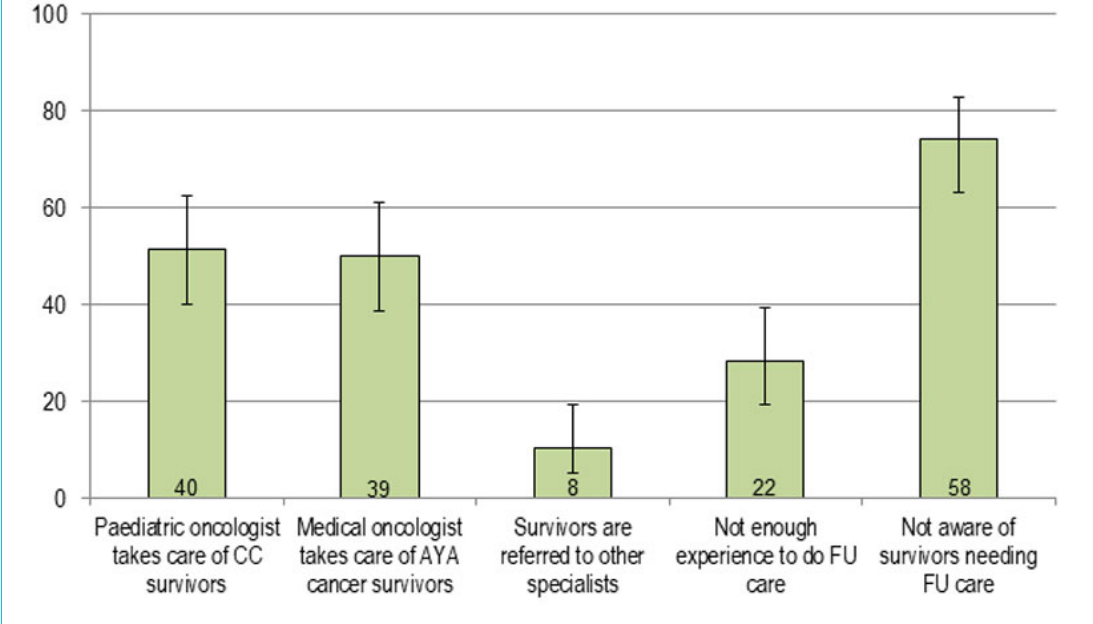
Figure S1: Reasons for not engaging in follow-up care (general practitioners and paediatricians).The bars represent the proportion of physi- cians (%), with 95% confidence intervals; the values in the bars represent the number of physicians who confirmed the respective reason.AYA = adolescent and young adult; CC = childhood cancer; FU =